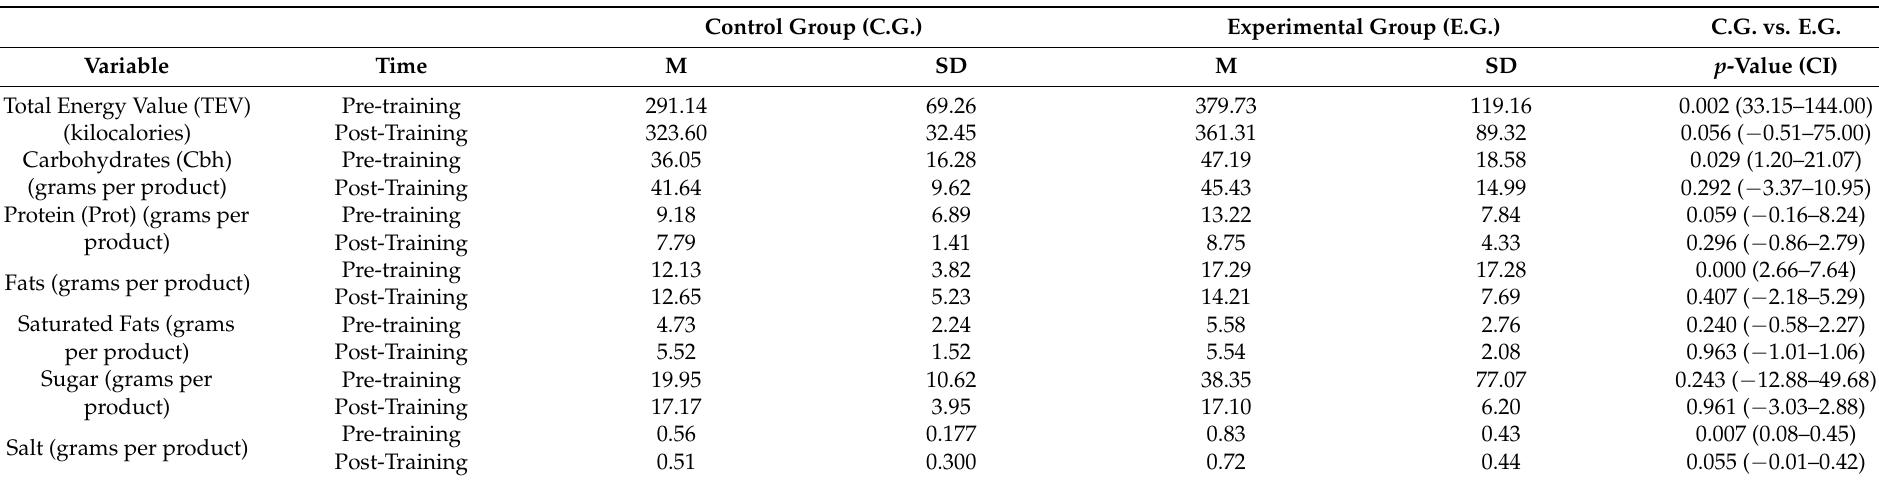
Table 2. Descriptive data of the analyzed variables. Average, Standard Deviation, regarding pre- and post-training and Group (control vs. experimental). Control Group (C.G.) Experimental Group (E.G.) C.G. vs.